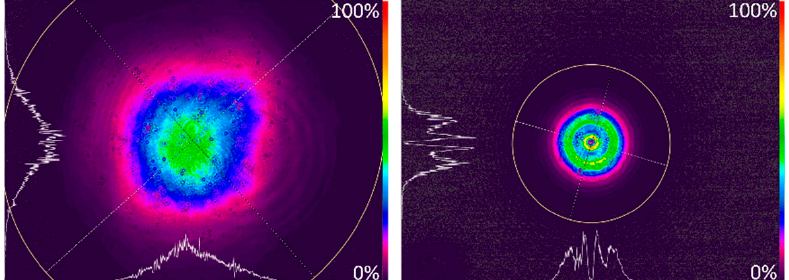
Figure 2. Beam profiler images (recorded with Ophir Spiricon SP928 camera and BeamGage software) of the laser pulses used for the blister-actuated laser-induced forward transfer (BA LIFT) process measured before the focussing optics. Left image: Raw beam with a diameter of 3.6 mm; Right image: “shaped” beam after passing through a 1.5 mm circular aperture. Utilized parameters: Pulse energy E p = 2.25 µJ and λ = 515 nm.